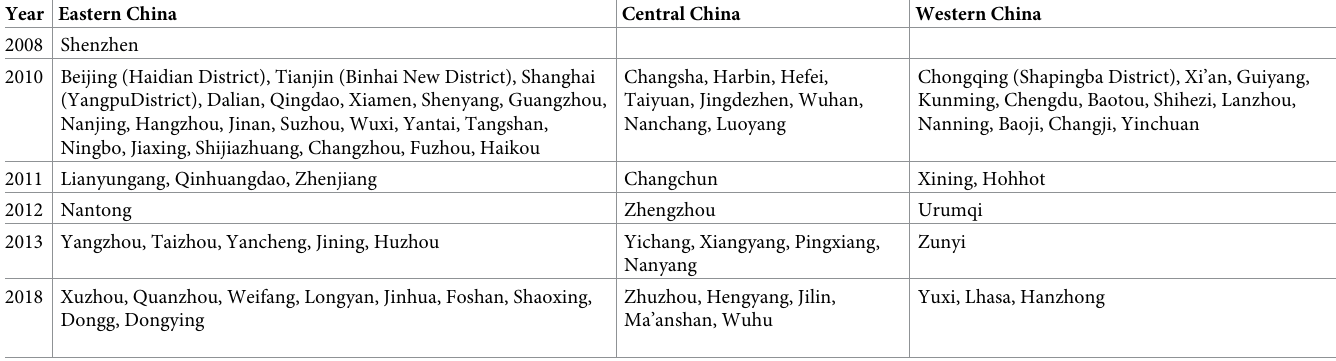
Table 1. Innovative city pilot